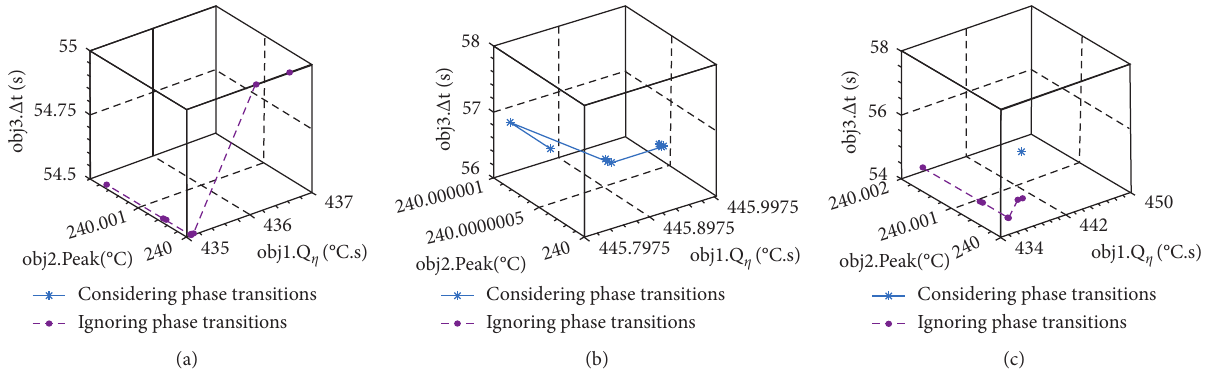
Figure 7: Numerical results of optimization of three objective functions: (a) ignoring phase transitions, (b) considering phase changes, and (c) relative position of results in the two cases.